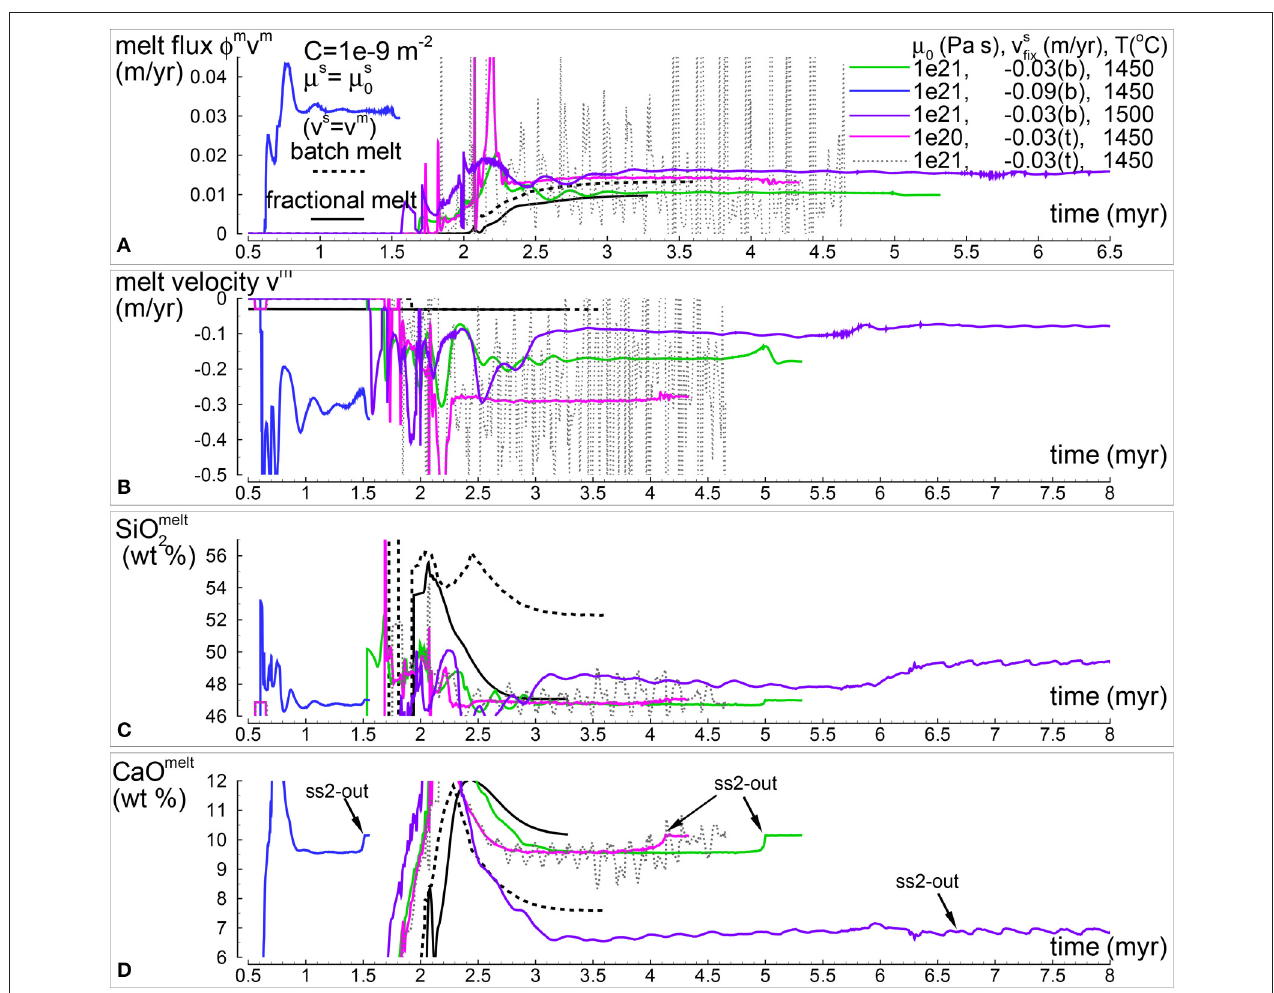
FIGURE 8 | Temporal variation of selected melt properties at the top side of the simulation for three models with µ s = µ s 0 , and permeability constant C = 10 − 9 m − 2 . Different lines correspond to simulations with different µ s 0 , velocity of the solid at the top (t) or bottom (b) and/or different temperature. Results from the batch melting model presented in the previous paper (MF1) and DFM with v s = v m are also included. (A) Melt flux ( φ m v m ), amount of melt per year that is extracted from the melt column. (B) Melt velocity (m/yr). (C) Melt composition: SiO 2 (wt %). (D) Melt composition: CaO (wt %). Complete data can be found in PHASE3-P.BRC4-5.DAT (batch melt v s = v m , zip file max-front1-data.zip in MF1), PHASE3B-P.YRC00.DAT (fractional melt v s = v m , black line), PHASE3B.YRC1.DAT (green line), PHASE3-P.YRC15.DAT (blue line), PHASE3B-P.YRC12.DAT (purple line), PHASE3B-P.YRC19.DAT (magenta line) and PHASE3B-P.YRC18.DAT (dotted black line) (all data included in the zip file max-front2-data.zip ).